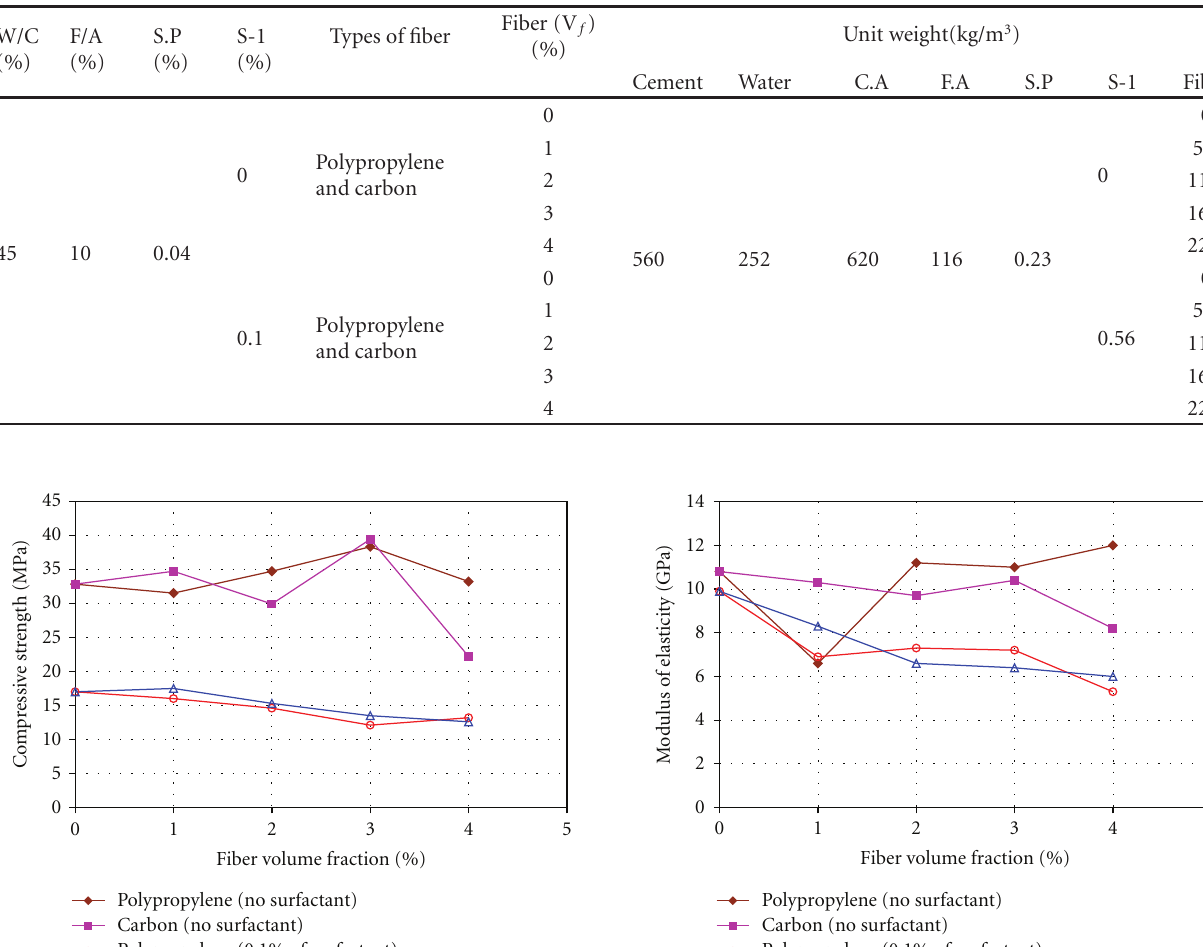
Table 4: Mixing proportions.